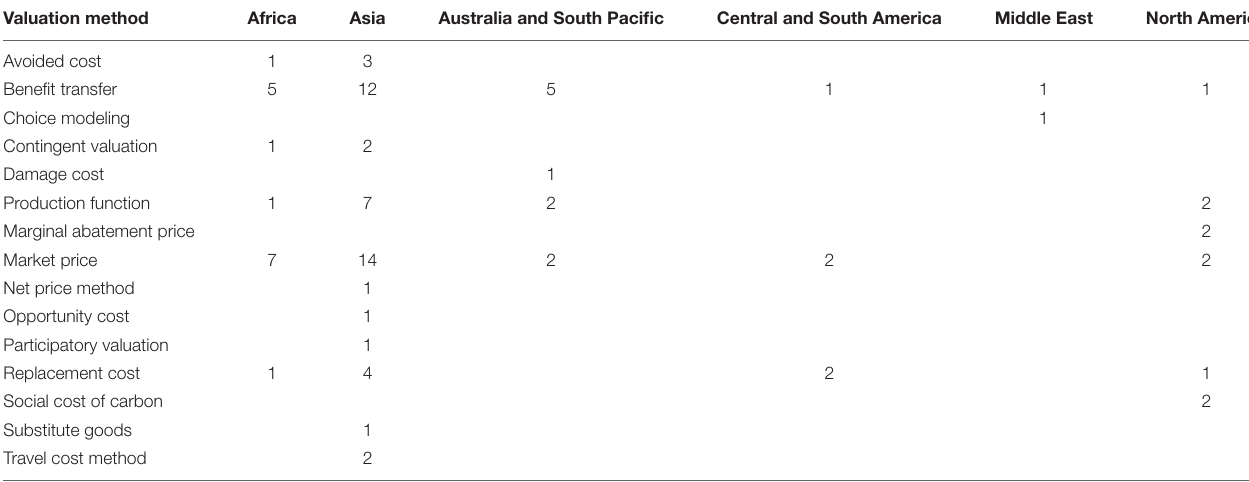
TABLE 2 | Count of studies published between 2007 and 2016 that used each valuation method by region of the case study. Valuation method